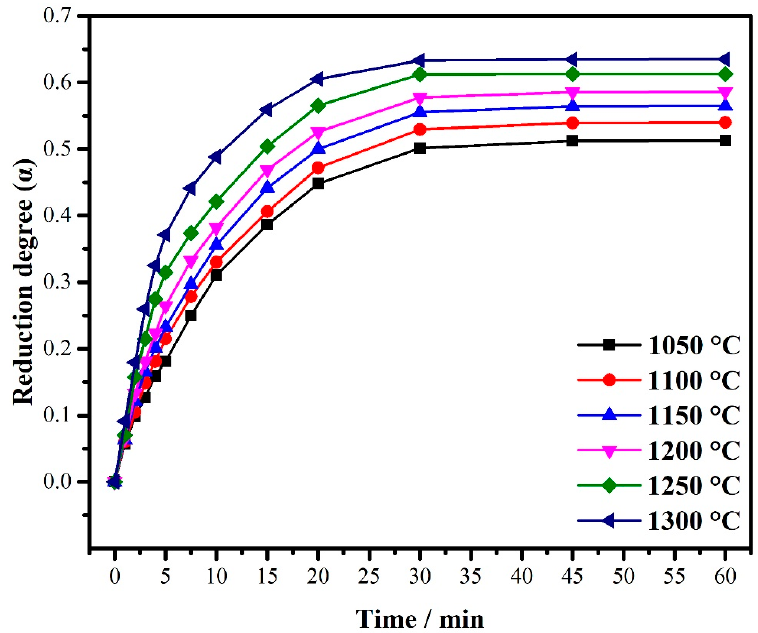
Figure 12. The reduction degree under various reduction temperatures and times.